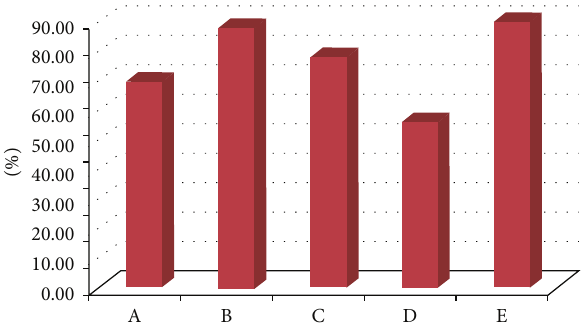
Figure 4: The percentage of obvious atrophy was similar in these groups. However, lower atrophic rate was found in Group